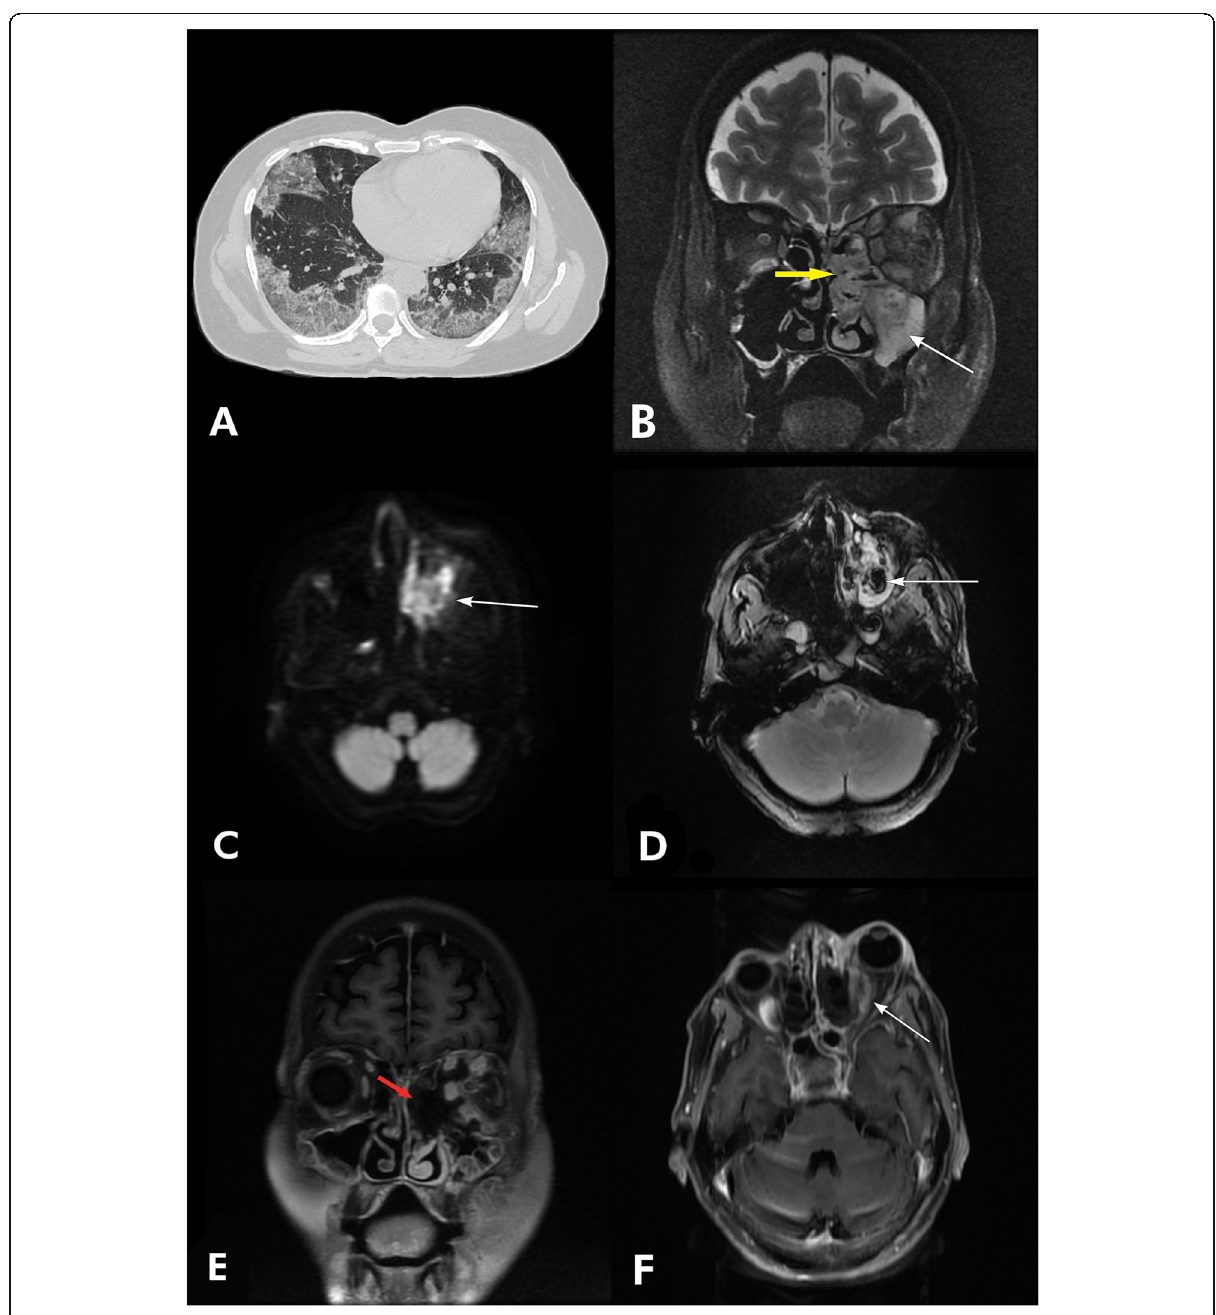
Fig. 1 a Axial HRCT thorax image showing ground-glass opacities in subpleural regions of bilateral lung parenchyma with “ crazy paving appearance. ” b Coronal T2 FS image showing mucosal thickening and collection in the left maxillary sinus (white arrow), left ethmoidal sinus, and left middle nasal turbinate (yellow arrow) with inflamed extraocular muscles. c Axial DWI image showing restricted diffusion in the left maxillary sinus and left middle nasal turbinate. d Axial GRE image showing foci of blooming in the left maxillary sinus (white arrow). e Coronal T1 post- contrast image showing area of non-enhancing soft tissue in left middle nasal turbinate and within the left maxillary antrum ( “ black turbinate sign ” ). f Axial T1 post-contrast image showing enhancement and inflammation involving extraocular muscles of left orbit causing